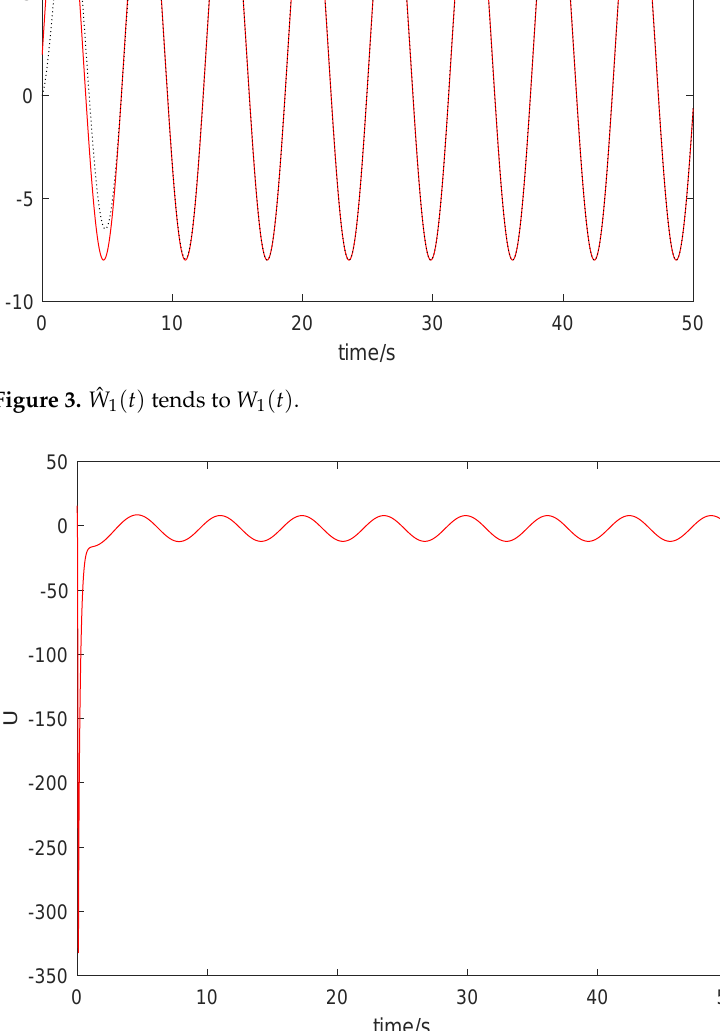
Figure 4. The state of control signal U ( t ) . Case 2: A = 100, C =